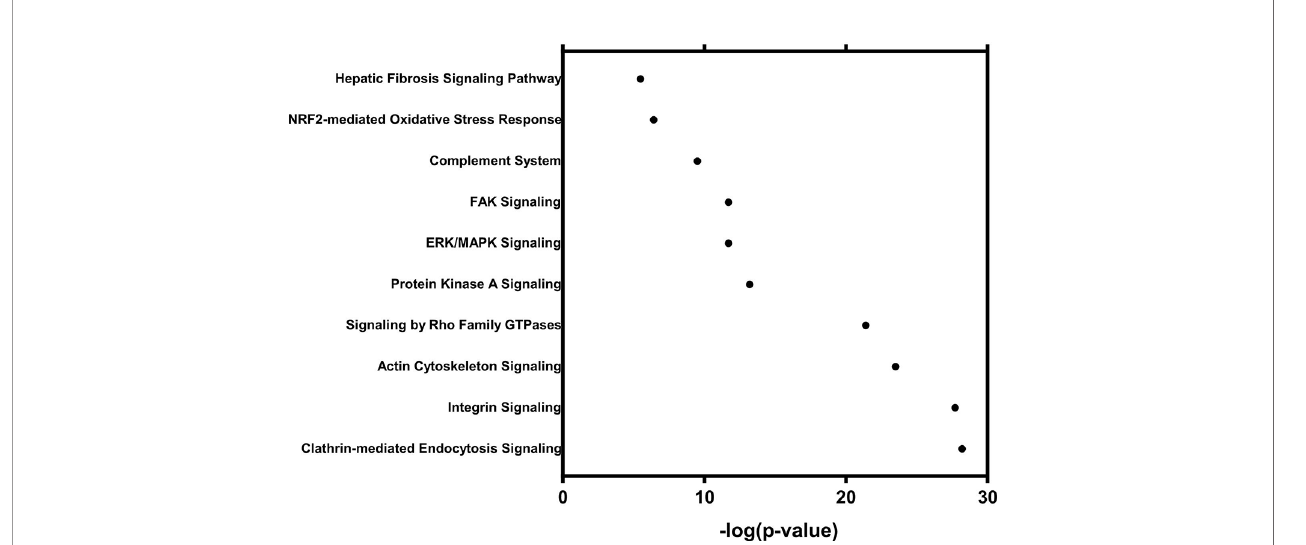
FIGURE 5 | Functional analysis with 1054 differentially expressed proteins in 98 patients.